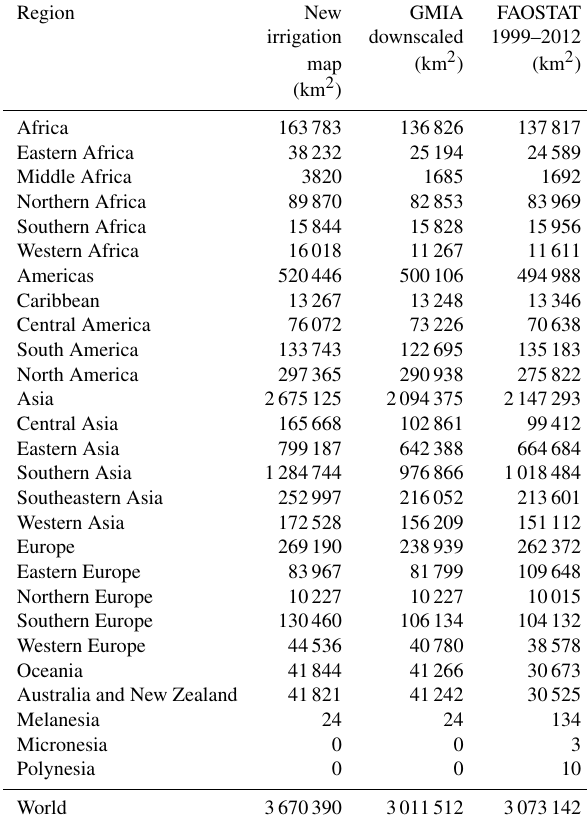
Table 4. The results of the new irrigation map compared to the downscaled GMIA and FAOSTAT (FAO, 2016b). The countries are grouped according to UN Geographical Regions (UN,